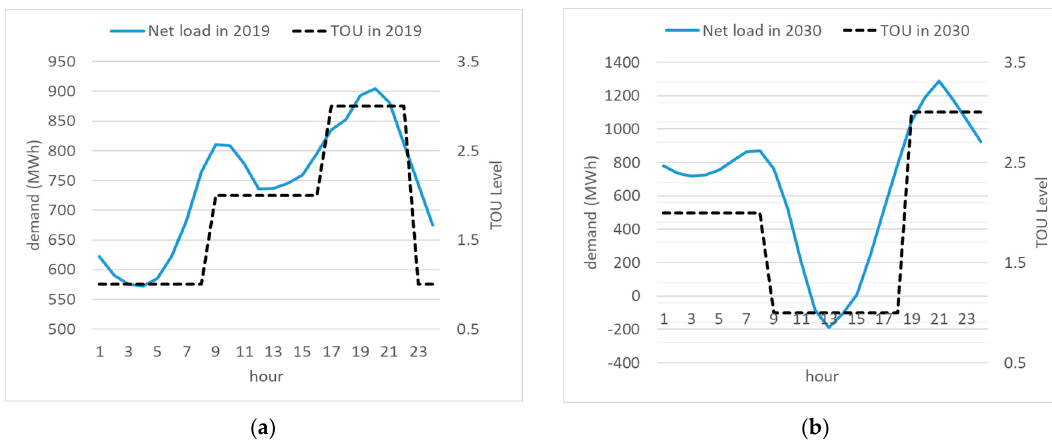
Figure 5. Time-of-use (TOU) structures based on the net load in 2019 and 2030: ( a ) 2019; ( b )